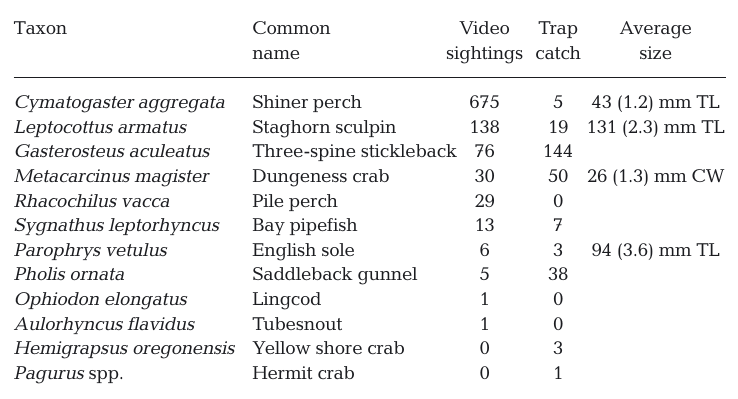
Fig. 3. Emergent surface area of Zostera marina , as calcu- lated by blade surface area × shoot density for each aquacul- ture type and position along the transect (N = 6). Error bars: ±1 SE Table 2. Species of fish and crabs sighted in underwater video footage and caught in minnow traps. Average size (SE) is also given for those measured in traps. Note: there were an additional 191 sightings that were unidentified. TL: total length; CW: carapace